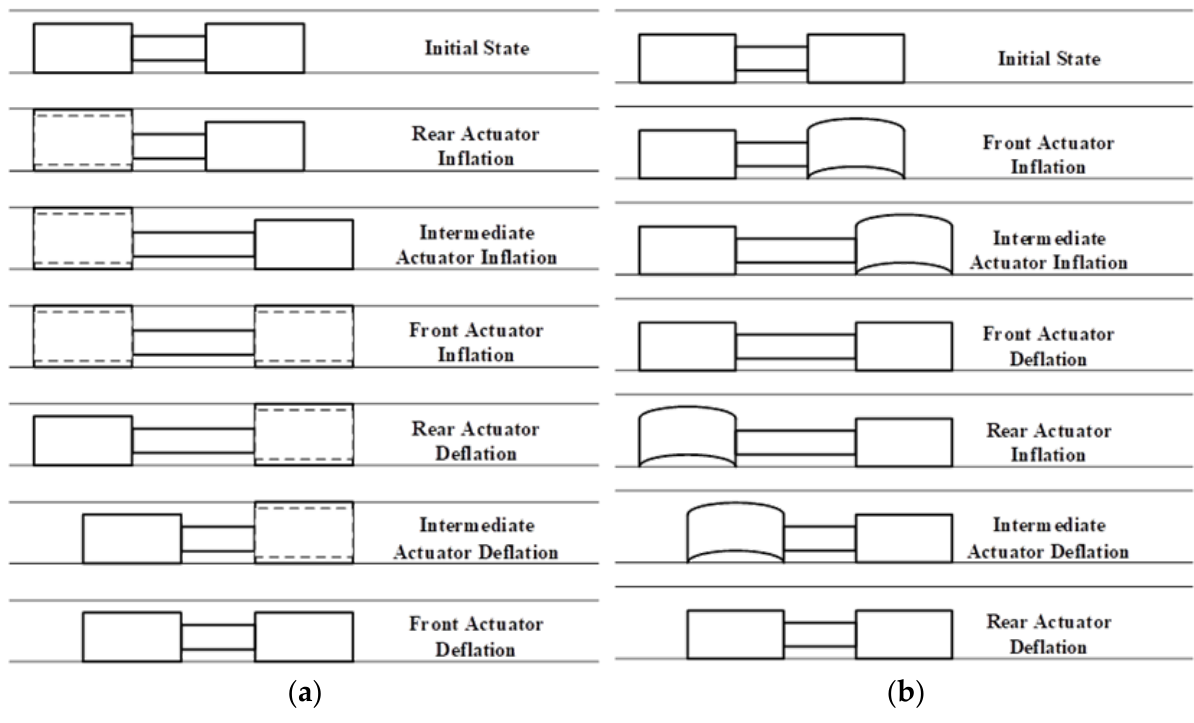
Figure 1. Motion diagram of peristaltic soft-bodied pipe robot. ( a ) Radial expansion motion. ( b ) Axial bending motion.